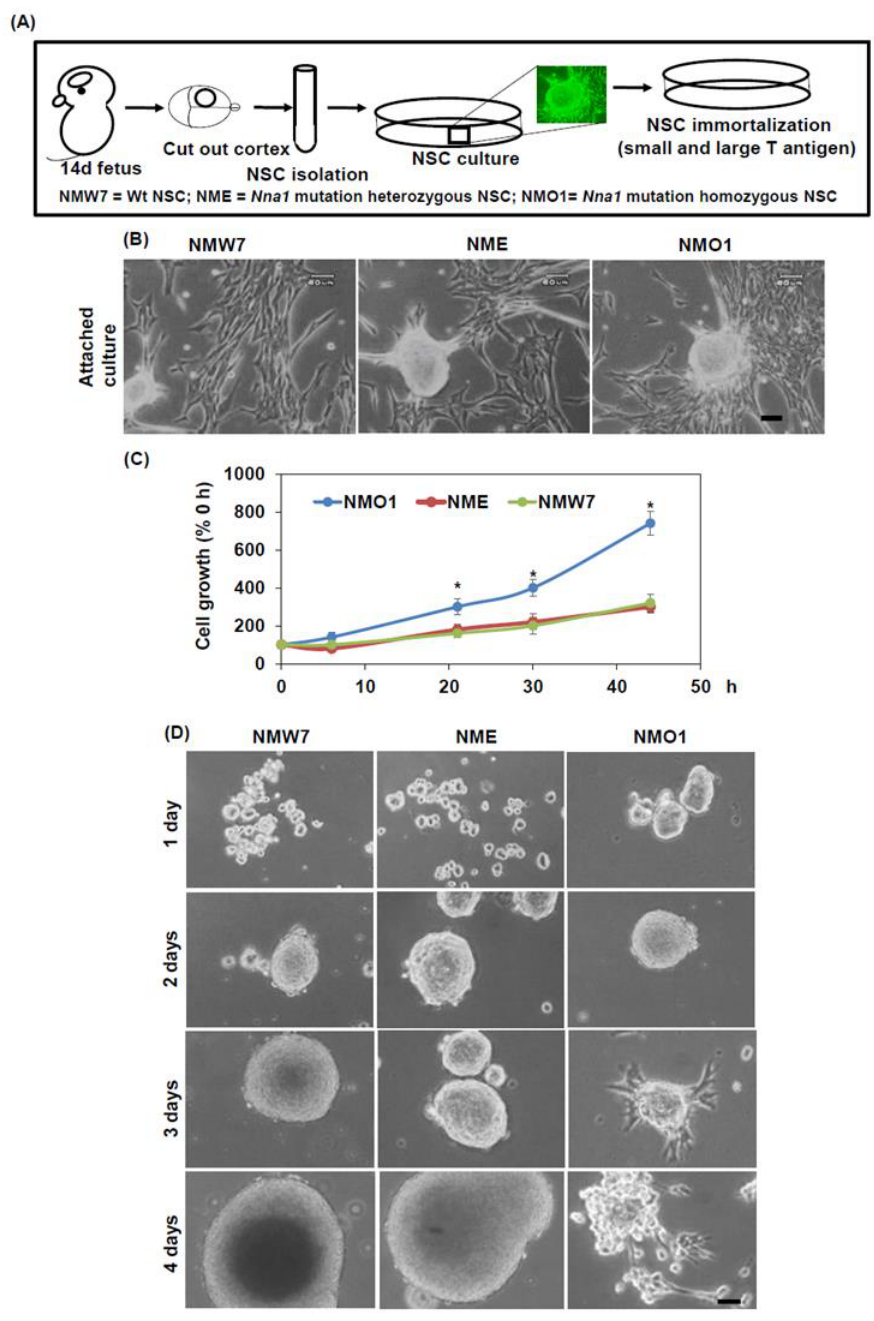
Figure 2. Establishment of the neural stem cell lines: Neural stem cell (NSC) lines were generated from wild-type, Nna1 mutation heterozygous, and AMS mouse embryos, as described in the Materials and Methods section: ( A ) the schematic design of the procedure to generate the NSC lines, where the neuronal stem cell line NMW7 was generated from wild-type, NME was generated from Nna1 mutation heterozygous, and NMO1 was generated from AMS mouse embryos. ( B ) The cell morphology of the three cell lines in attached culture condition are shown here. ( C ) NSC cell lines cultured in attached conditions to analyze their growth rate, where viable cell numbers were counted in a time-dependent manner and presented as fold increases compared to an initial number of cells (day 0), and the averages ± SD of 3 independent experiments are shown. ( D ) The results of the neurosphere assay are shown here. NMW7, NME, and NMO1 cells were cultured in neurosphere culture conditions, and neurosphere formation was evaluated in a time-dependent manner using a cell culture microscope. Numerical data are presented as average ± SD of at least 3 independent experiments. Statistical significance is denoted as follows: * p < 0.05 vs. NMW7 or NME. Scale bar, 60 µ